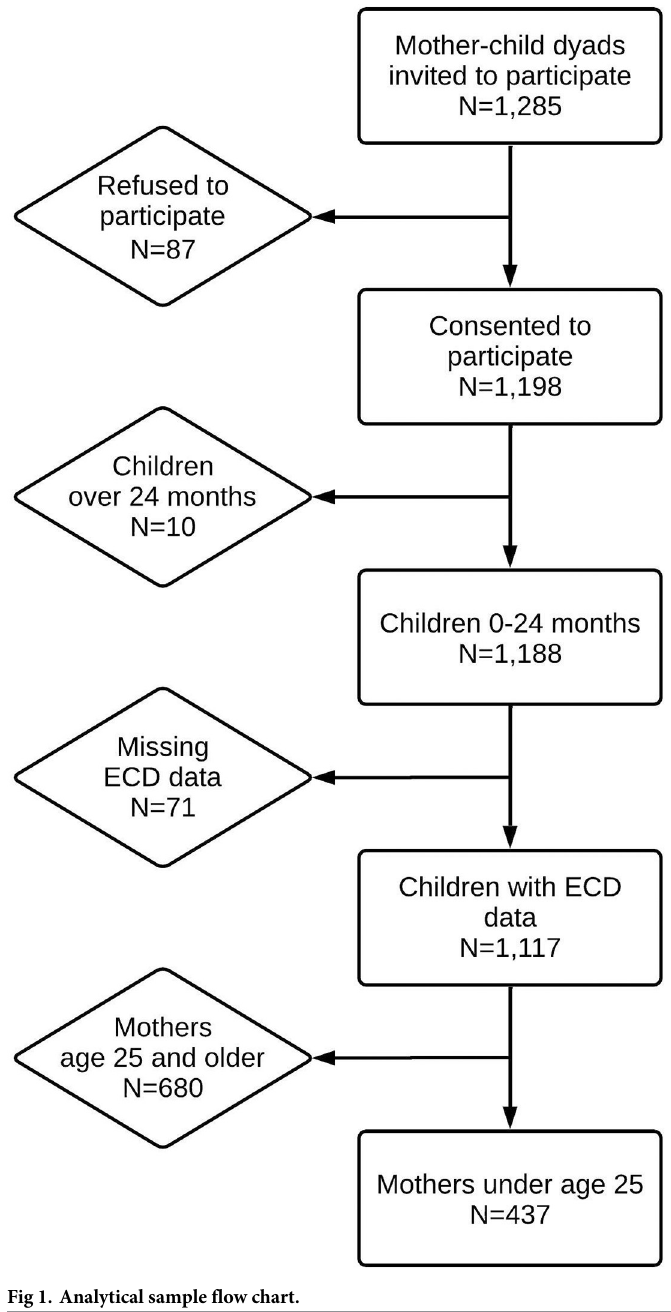
Fig 1. Analytical sample flow